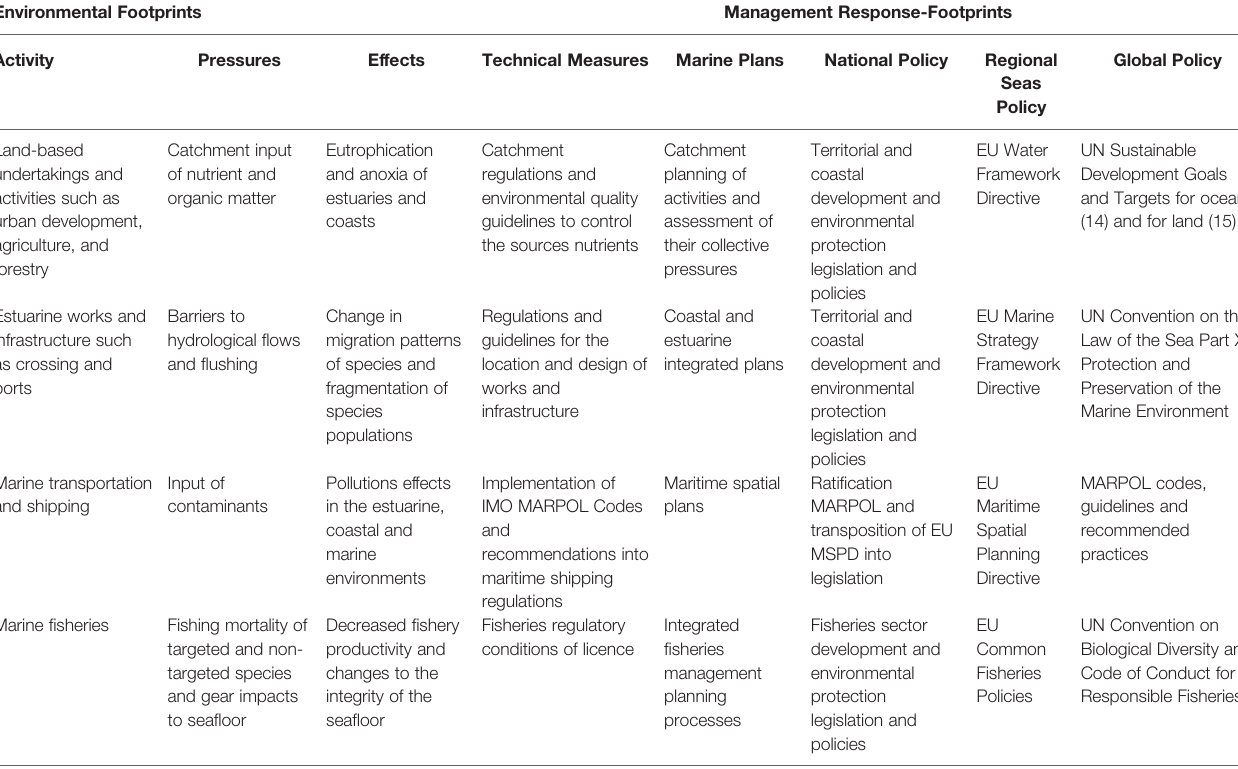
TABLE 4 | Examples of linkages between the different types of footprints (Elliott et al., 2020a). Environmental